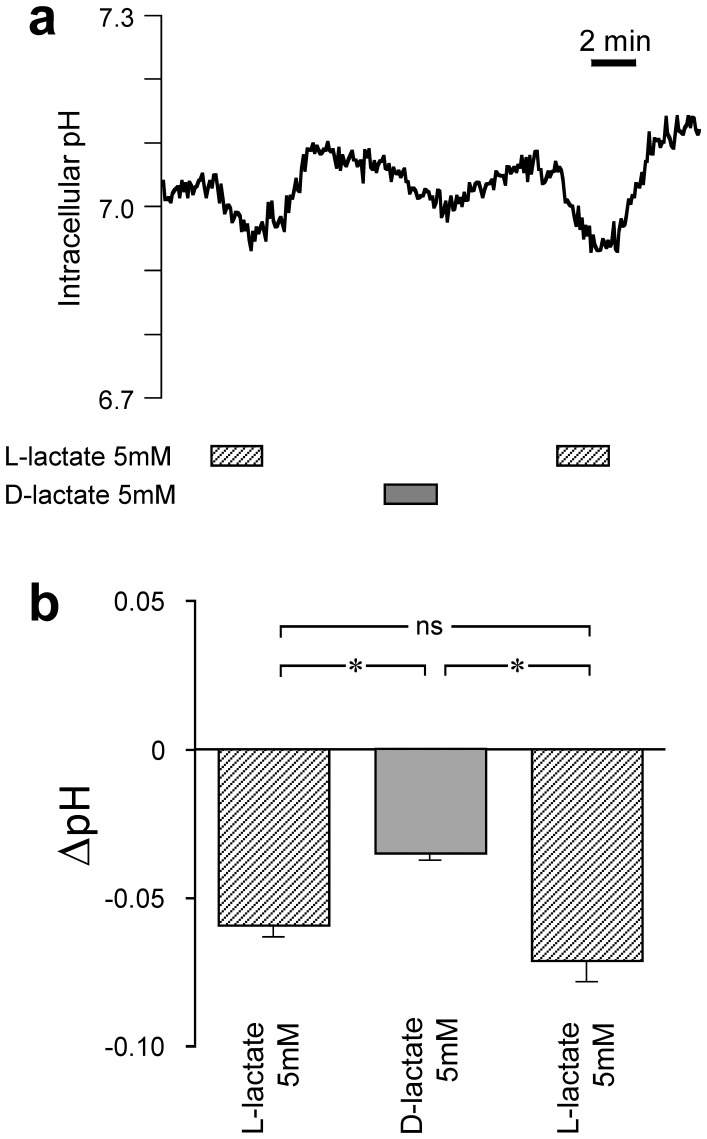
Intracellular pH effects of lactate isomers on cortical neurons.Intracellular pH measured using BCECF and calibrated in situ in cortical neurons. (a) Original pH trace during sequences of L- and D-lactate application. (b) Summary of acidification (pH amplitude) measured during L- and D-lactate application. (n = 39 cells; 7exp).